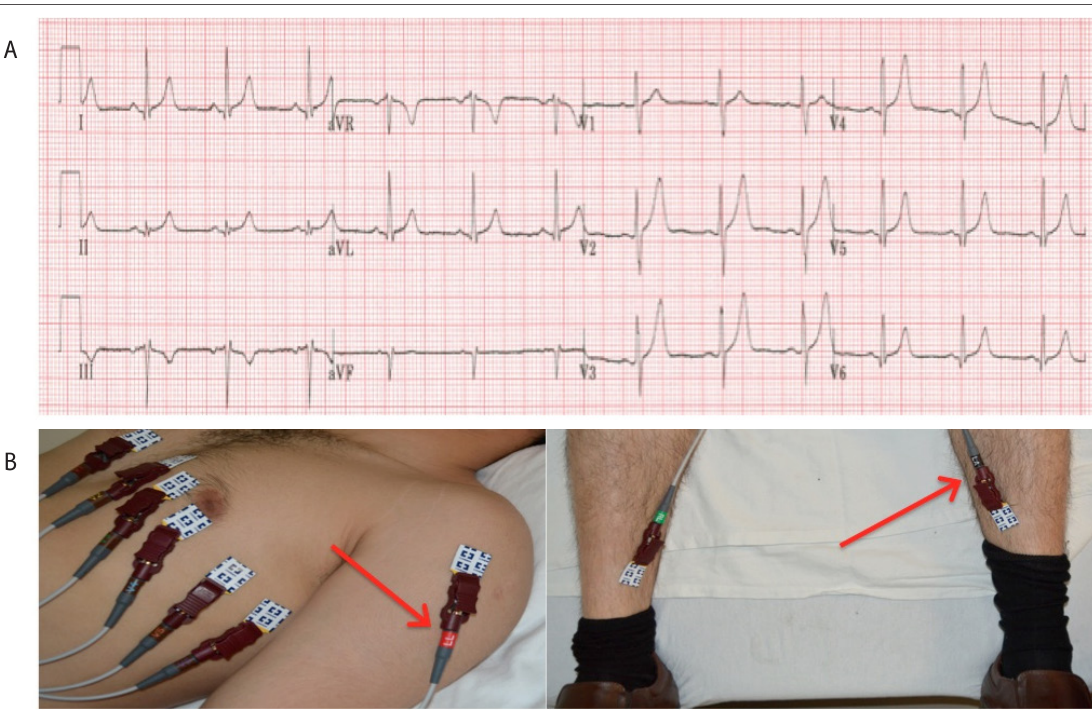
Figure 4. 12 lead ECG depicting left arm and left leg reversal. (A) ECG recording. (B) Arrows point to reversal of leads on left arm and left